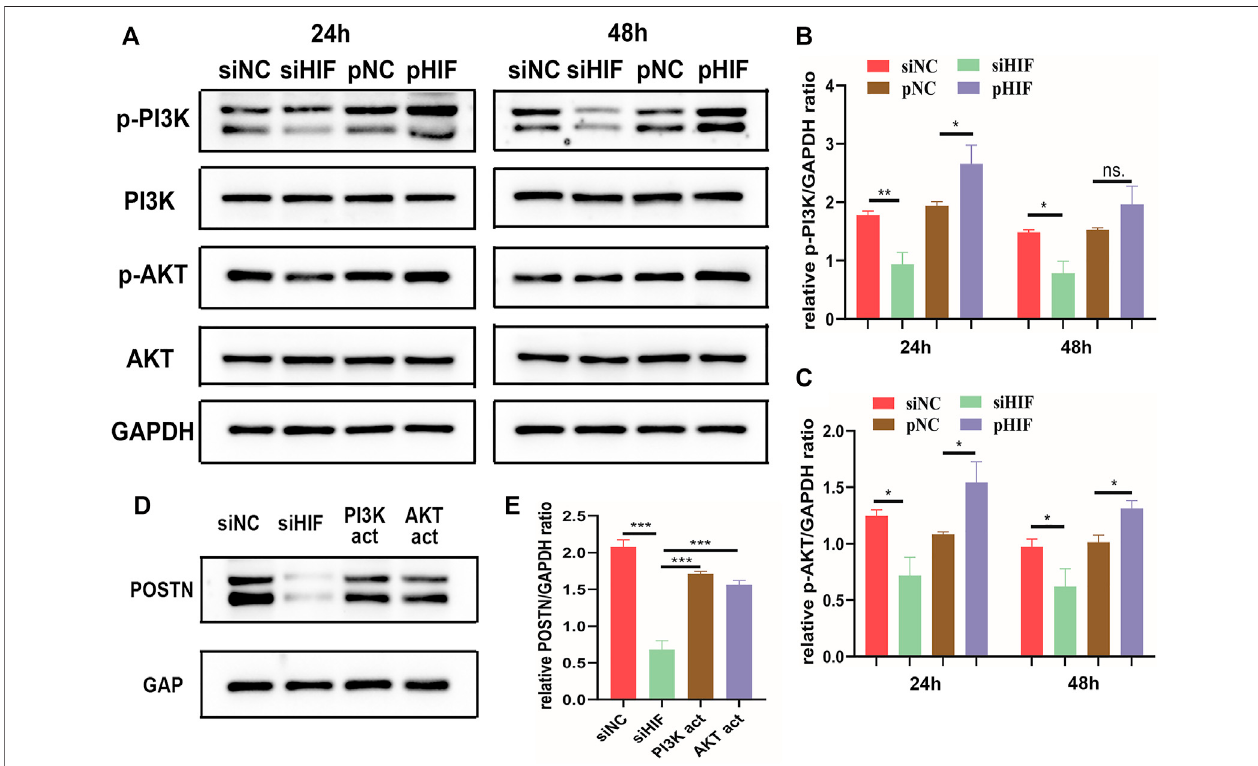
FIGURE 5 | HIF-1 α induces POSTN expression via PI3K/AKT signaling pathway. (A – C) Western blotting analysis of the phosphorylation of PI3K and AKT in transfectedPDSCsandsemi-quanti fi cation. (D,E) WesternblottingofPOSTNexpressionintransfectedPDSCsinpresenceorabsenceofPI3Kactivator740-YP(30 μ g/ ml) orAKTactivator SC79 (5 μ g/ml),and semi-quanti fi cation. *indicates thesigni fi cance testsbetweengroups:* p < 0.05,** p < 0.01,*** p < 0.001; andns: nosigni fi cant difference.